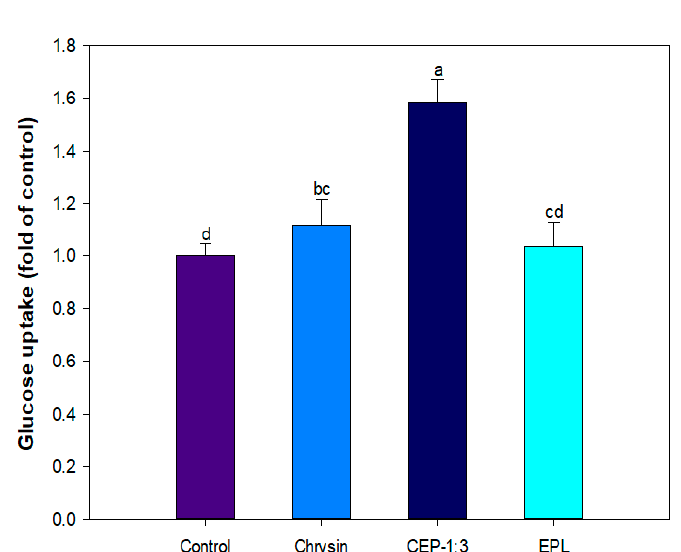
Figure 7. Effect of ( A ) phospholipid matrix, ( B ) dose-dependent behavior, and ( C ) sample filtration on glucose uptake in C2C12 skeletal muscle cells. (A) Chrysin, CSP-1:3 and CEP-1:3 were fully solubilized using DMSO (1%, v/v ), (B) The dose-dependent effects of samples were compared. (C) Chrysin and CEP-1:3 obtained after filtration of samples (equivalent to 1 mg/mL chrysin) through a 0.45 μ m syringe filter. All samples were treated for 24 hours and glucose uptake was determined. Bars with different letters indicate significant differences at ( p < 0.05).